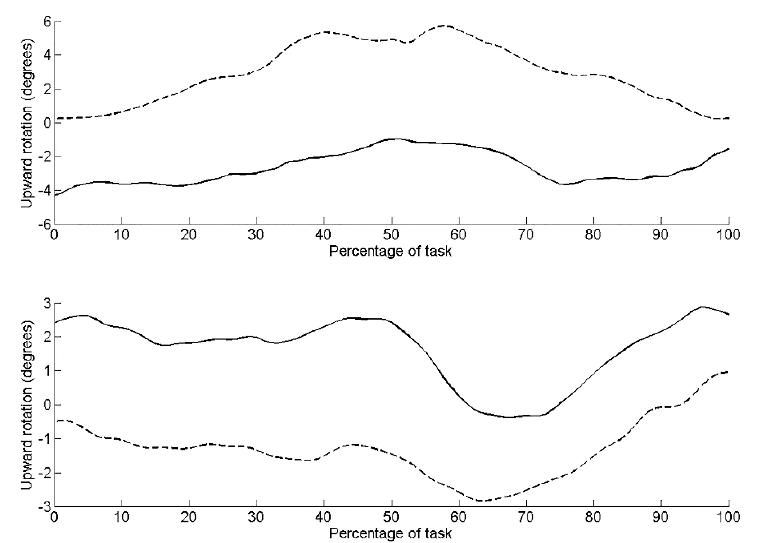
Figure 4. Hip flexion during the seated hip flexion task for the left side (upper graph) and right side (lower graph). Dashed line represents pre-intervention, solid line represents post-intervention.